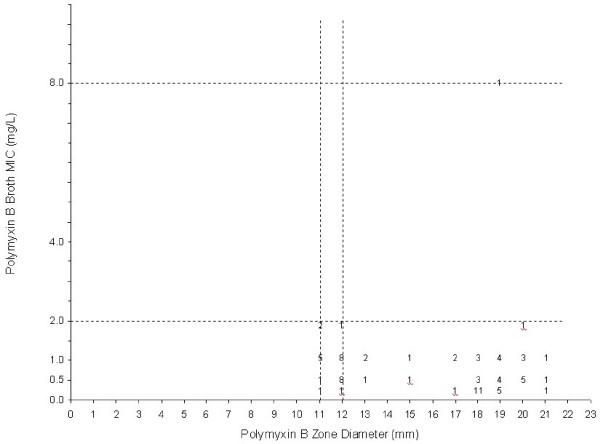
Comparative results between broth microdilution MICs and 300 U disc zone diameters for Polymyxin B (PB) tested against 78 carbapenem-resistant P. aeruginosa isolates. The broken lines represent the breakpoint values for Polymyxin B by disc diffusion method [10].